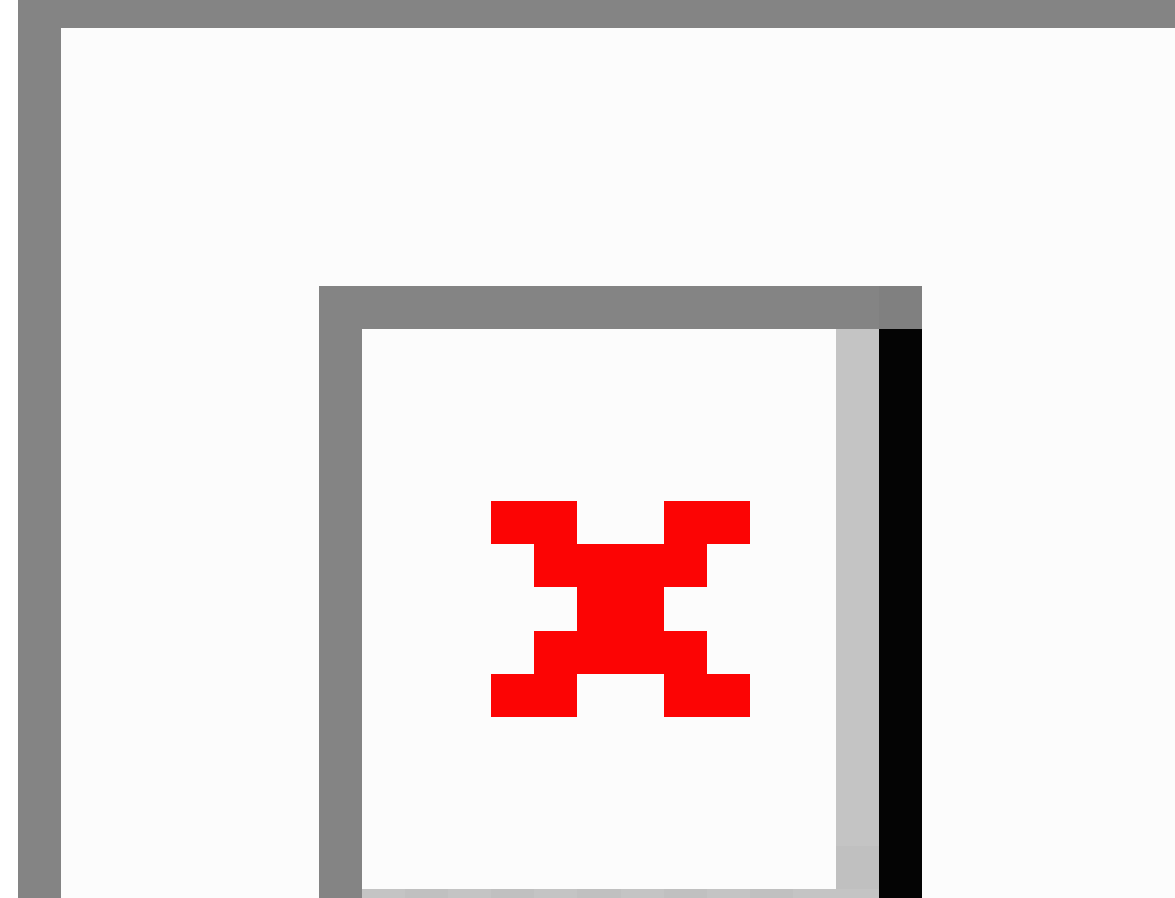
Figure 3. The 95% limits of agreement for phase 1 laboratory-based convergent energy expenditure measurement biases, categorized by activity intensity